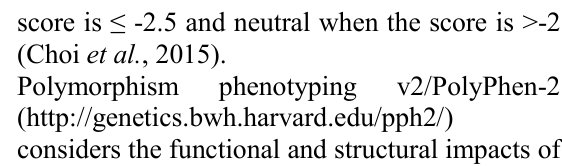
Fig. 1. Schematic flowchart of the steps of the